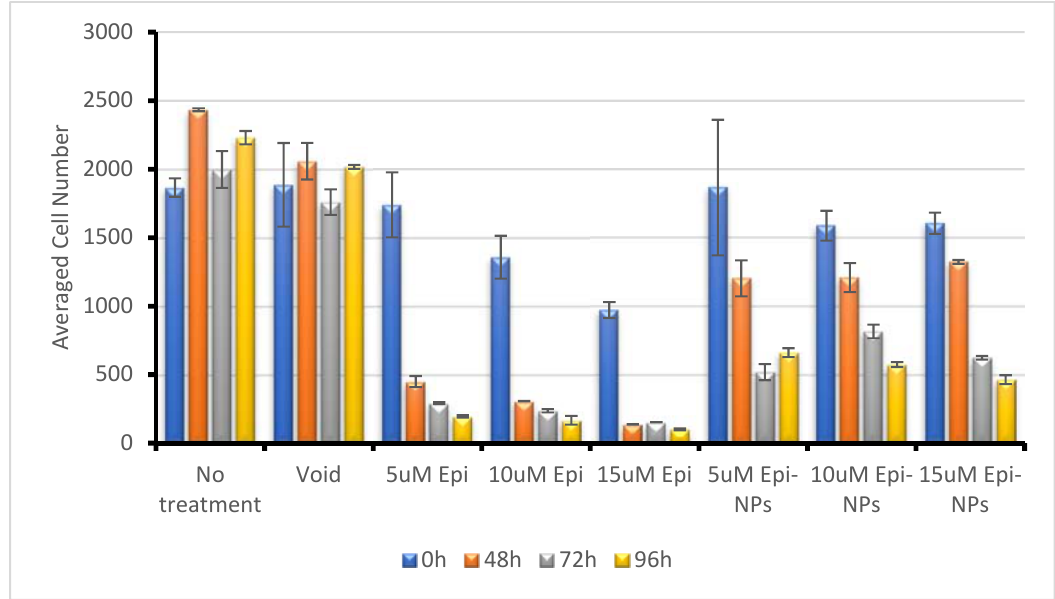
Figure 10. Average cell number for MCF-7 cells treated with epirubicin (5 µM, 10 µM and 15 µM), epirubicin-loaded nanoparticles (5 µM, 10 µM and 15 µM) and void nanoparticles for 0, 24, 48, 72, 96 h.